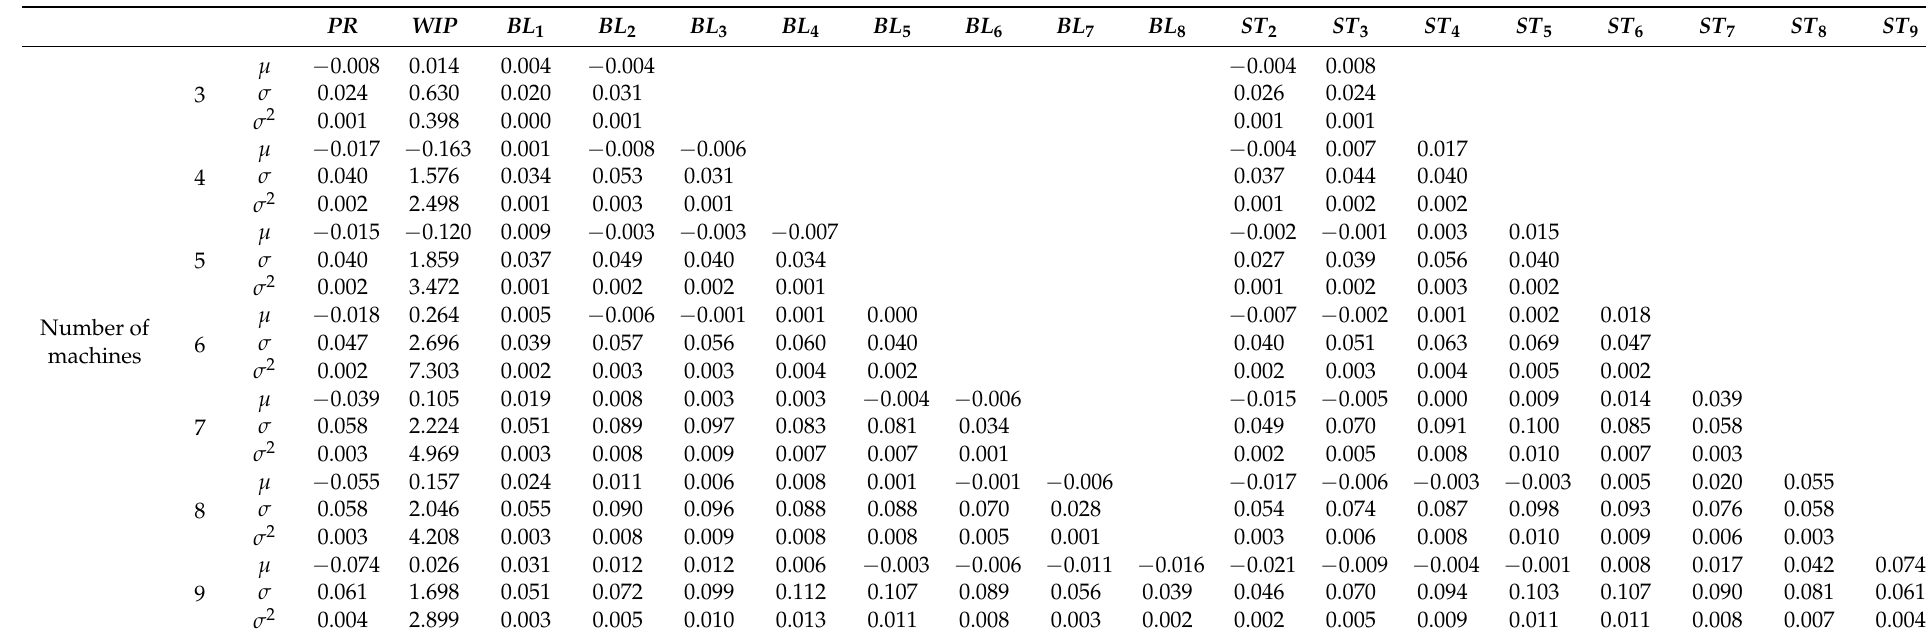
Table 2. FSM: mean value, standard deviation, and variance of the relative error concerning the analytical